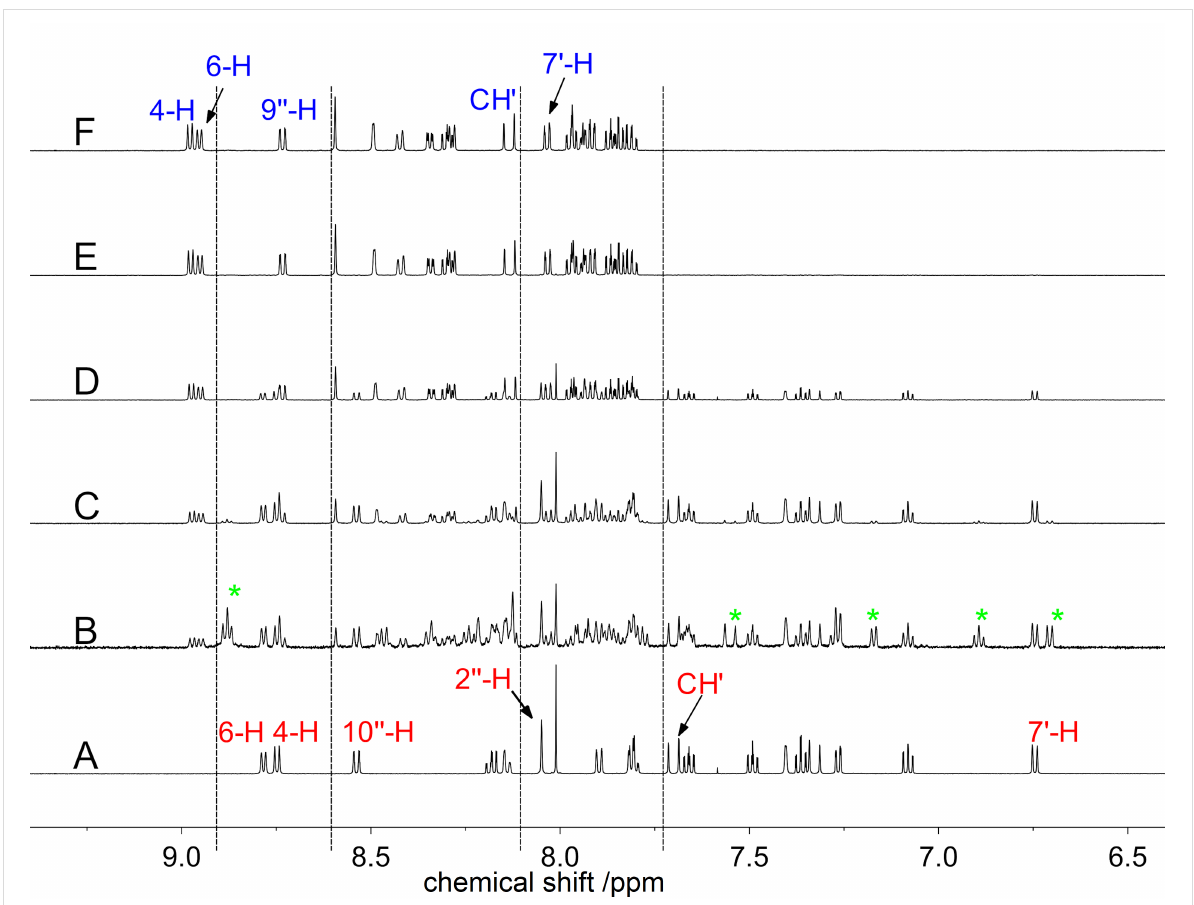
Figure 5: 1 H NMR spectra (600 MHz, 6.4–9.4 ppm) of 3a ( c = 2.0 mM) in the absence (A) and in the presence (B–F) of Cu 2+ (B: 0.50 mM, C: 1.0 mM, D: 2.0 mM, E: 3.0 mM, F: 4.0 mM) in CD 3 CN (cf. Scheme 3). The green asterisks highlight the clearly distinguishable signals of the third signal set of a reaction intermediate (B) in addition to the signal sets of 3a (A) and 4a